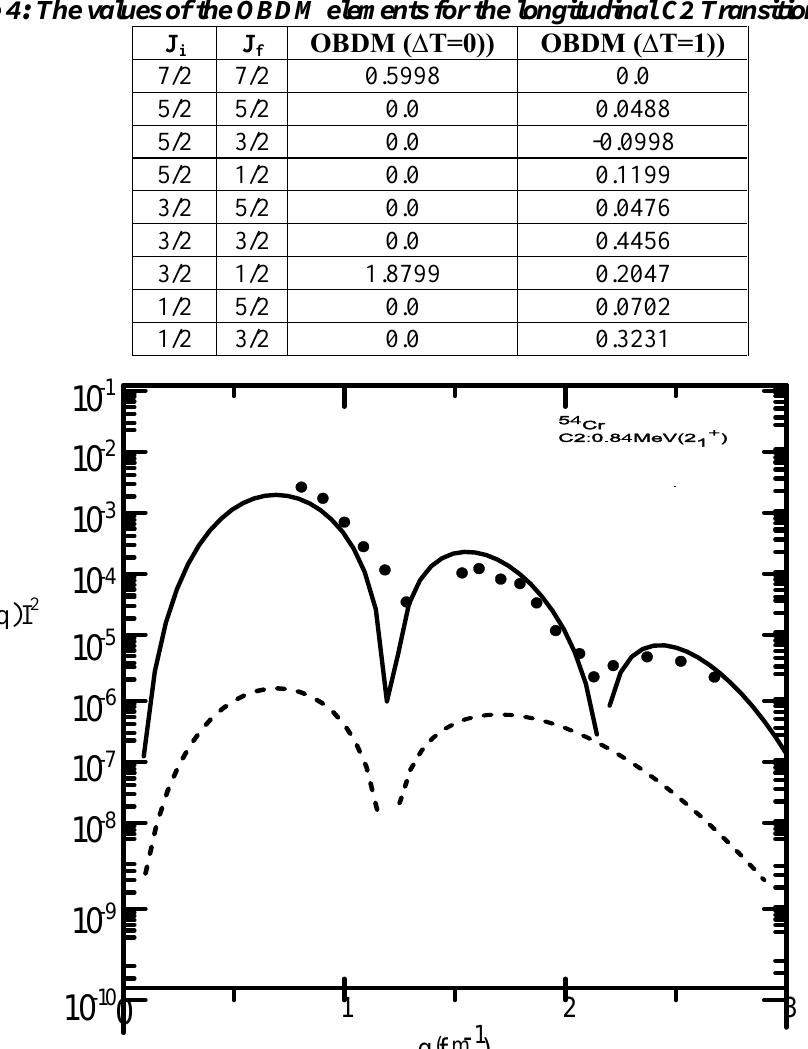
Fig. 3: Inelastic longitudinal form factors for the transition to the with and without core-polarization effects, the experimental data are taken from